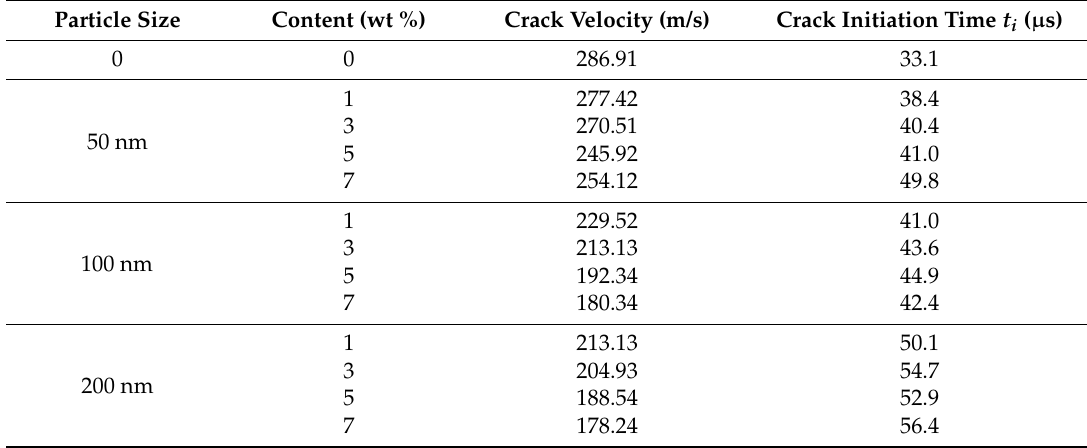
Table 2. Average steady state crack propagation velocity and crack initiation time of nano-Al 2 O 3 -filled epoxy